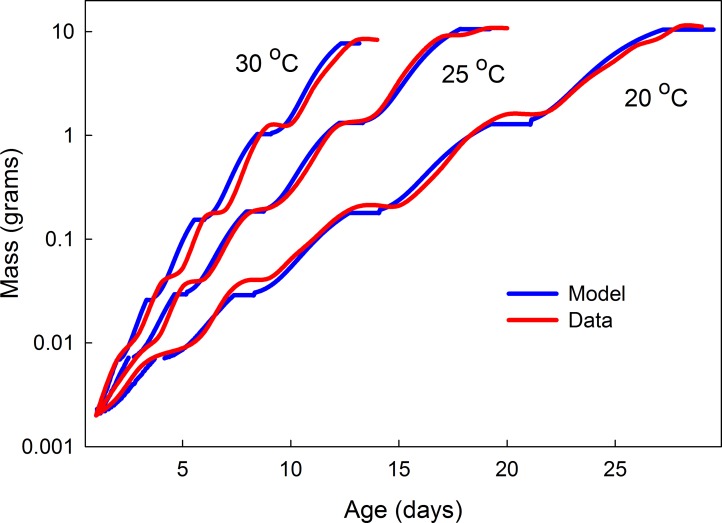
Comparison of model simulations and empirical data.Growth trajectories at three different temperatures (red) and model simulations at those temperatures (blue).